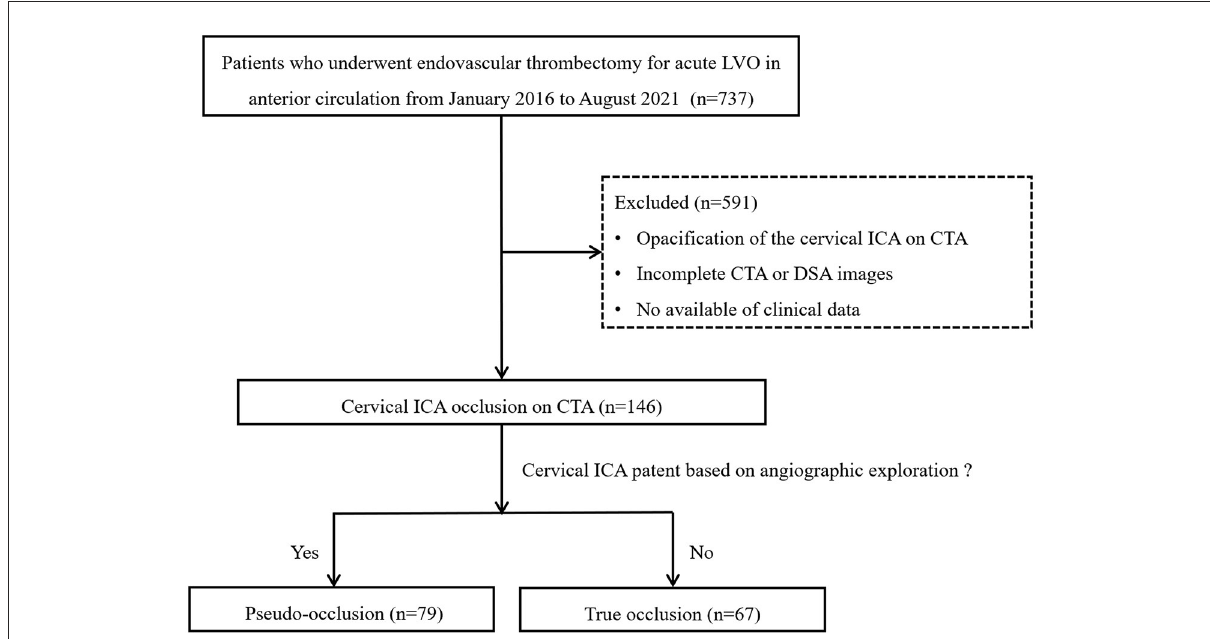
FIGURE1 Flowchart of patient selection. LVO, large vessel occlusion; ICA, internal carotid artery; CTA, computed tomography angiography; DSA, digital subtraction angiography.